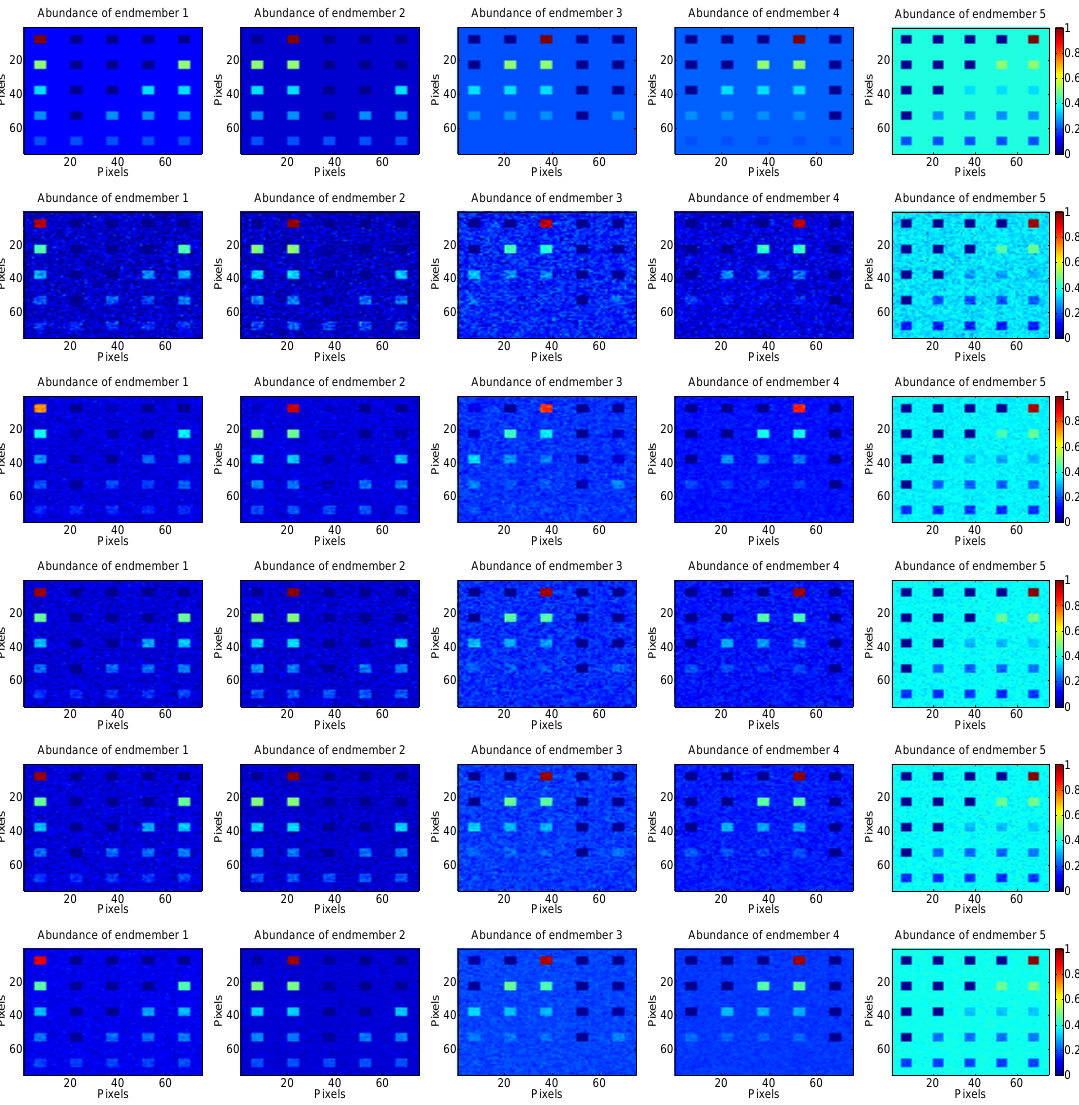
Figure 4. Abundance maps of 5 endmembers estimated with different methods under Gaussian white noise with both pure and mixed regions having 75 × 75 pixels and 224 bands. From top to bottom: ground truth, SUnSAL ( λ = 10 − 2 ), CLSUnSAL ( λ = 1), CUSAL-SP ( λ = ˆ s × 10 − 3 ), SU-NLE ( d = 1) ( λ = 10 − 2 ) and SU-NLE ( d = 2) ( λ =